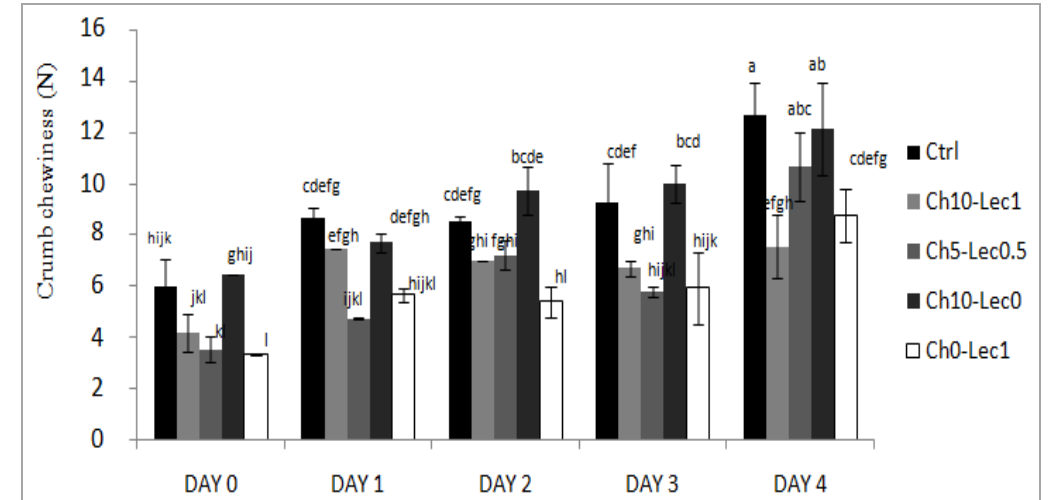
Figure A1. Crumb chewiness of the different formulations during storage at 25 °C. Foods 2020 , 9 , x FOR PEER REVIEW